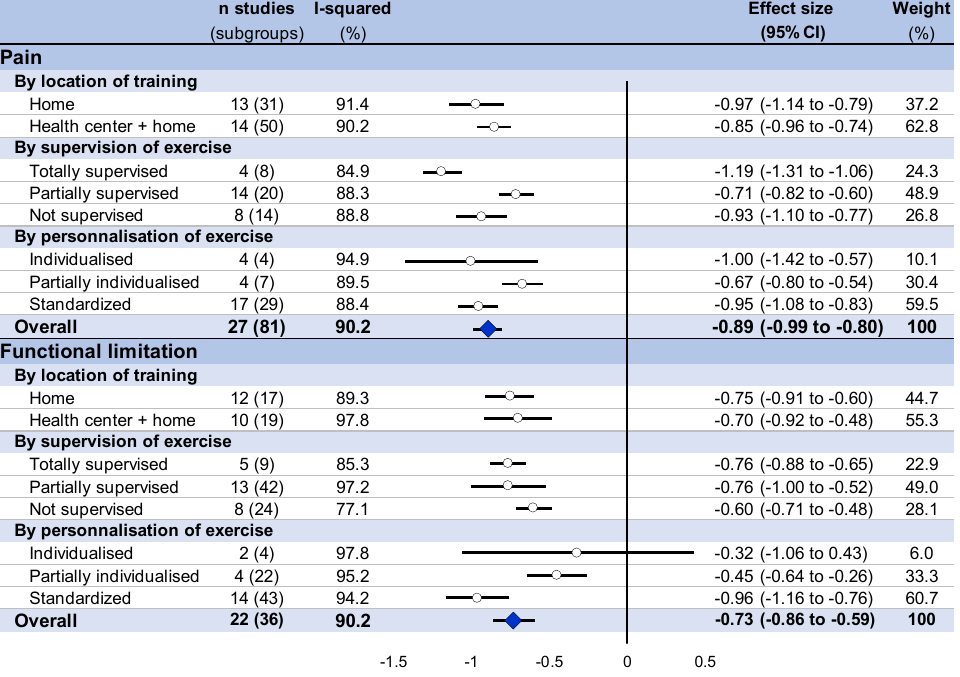
Figure 3. Summary of meta-analysis on the effect of home-based exercise on pain intensity and functional limitation, stratified by setting (exclusive home-based training versus home-based and other setting), supervision, and standardization of training.